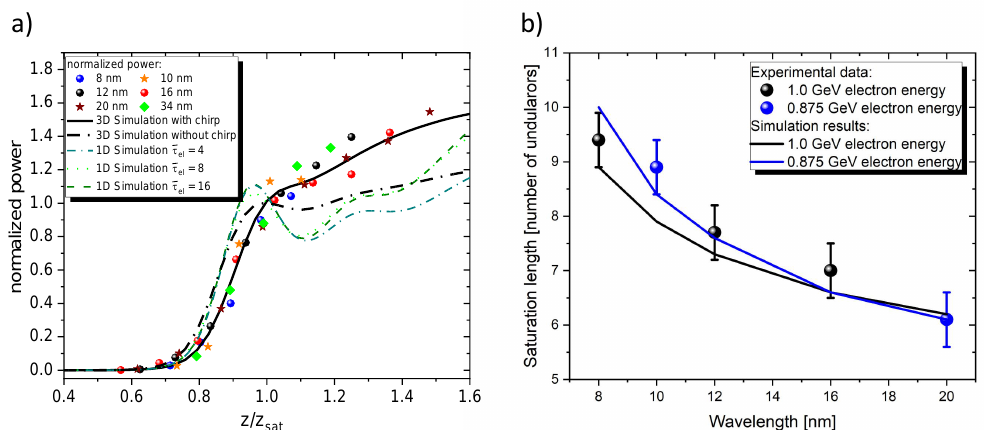
Figure 5. ( a ) Development of the power (pulse energy divided by pulse duration) along the un- dulators for different pulse durations. The chirped 3D model agrees significantly better with the experimental data as compared to the nonchirped 3D model, while the oscillatory behavior predicted by the 1D model is not reproduced at all. ( b ) The measured as well as the simulated (3D model with chirp) saturation length is plotted as functions of the FEL wavelength for two different FEL setups. Error bars are estimated as ± 0.5 undulators from the analysis. The electron bunch energy for the 34 nm measurement was much smaller than for the other measurements; thus, it is not included in the